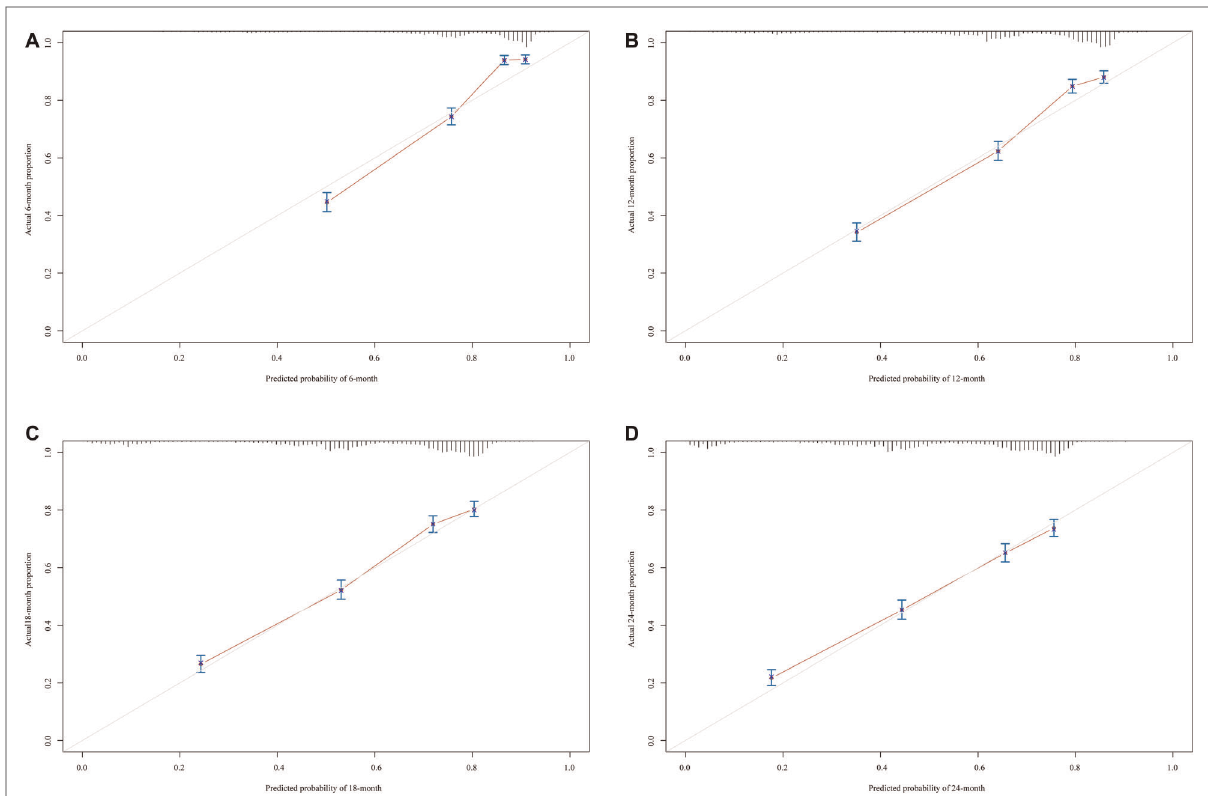
FIGURE 5 The calibration curves of the prediction model for predicting the 6-month mortality ( A ), 1-year mortality ( B ) and 18-month mortality ( C ) and 2-year mortality ( D ) of metastatic ovarian cancer